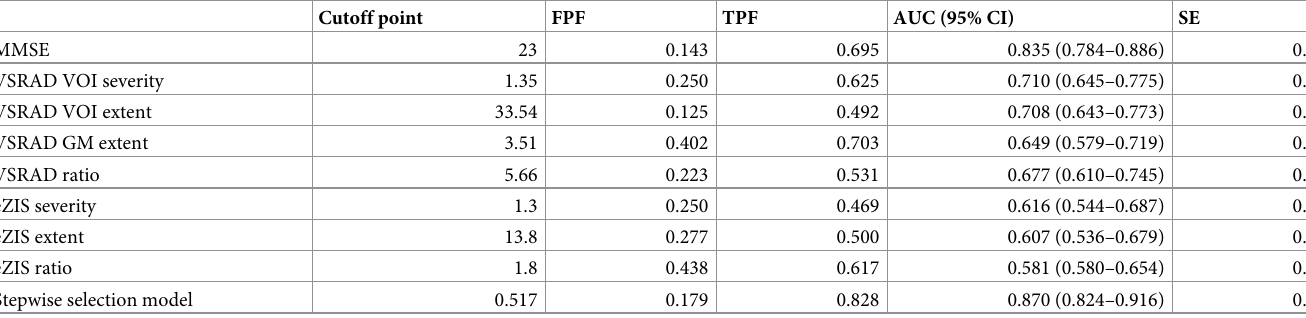
Table 3. Results of the receiver operating characteristic curve analyses.